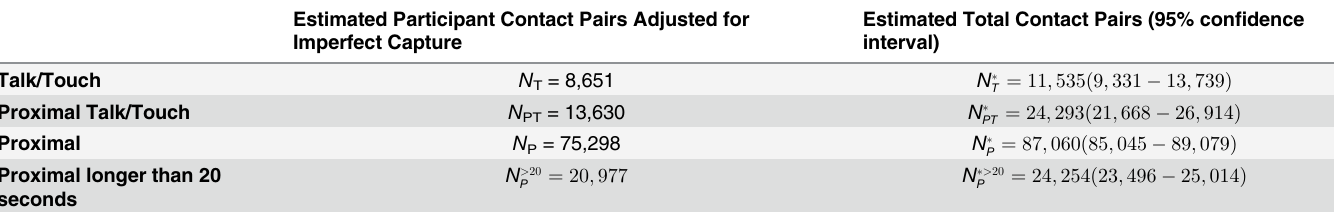
Table 6. Estimated class-time and lunch contact pairs based on duration-specific probability of capture.